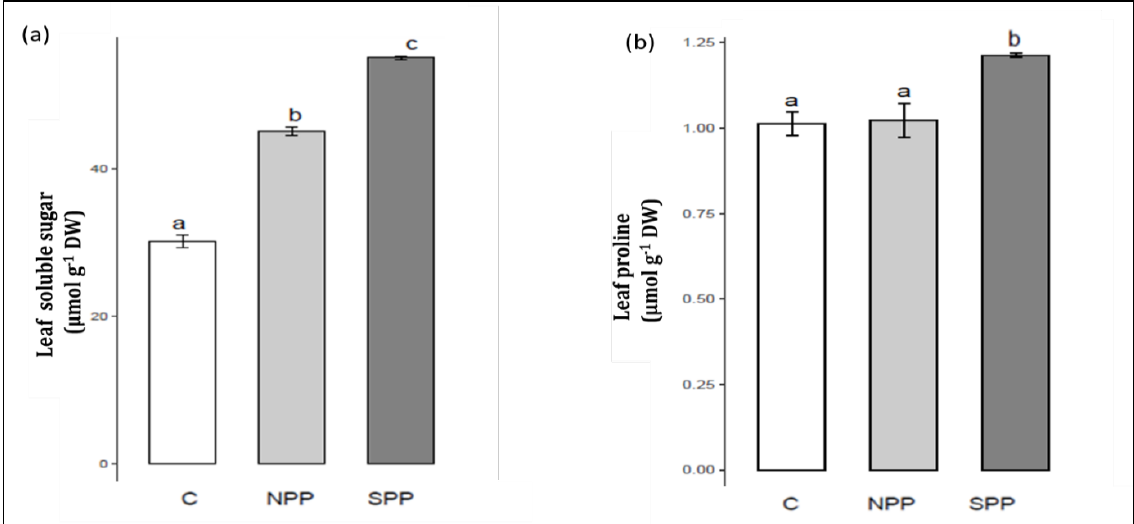
Figure 4. Effect of cross-tolerance on soluble sugar ( a ) and proline ( b ) concentrations of olive leaves subjected to subsequent drought stress. Significant differences between the means (at p < 0.05, according to ANOVA) appear with different letters. Values are means ± standard error ( n = 6), where ‘ n ’ is the number of replicates for each group.